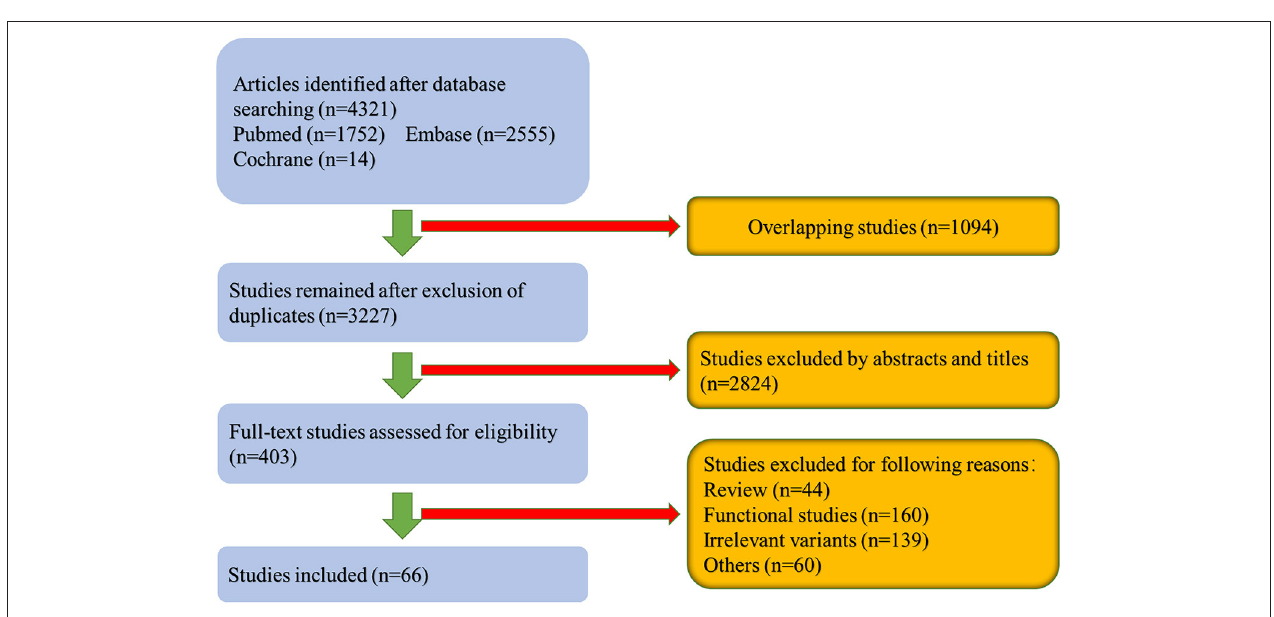
FIGURE 1 | Flowchart showing the literature screening process.